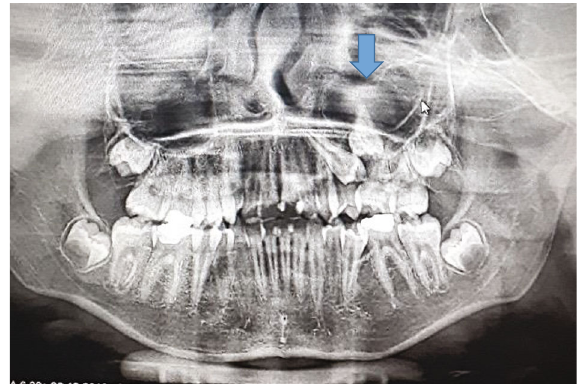
Figure 7: Ectopic second premolar tooth and accompanying lesion.